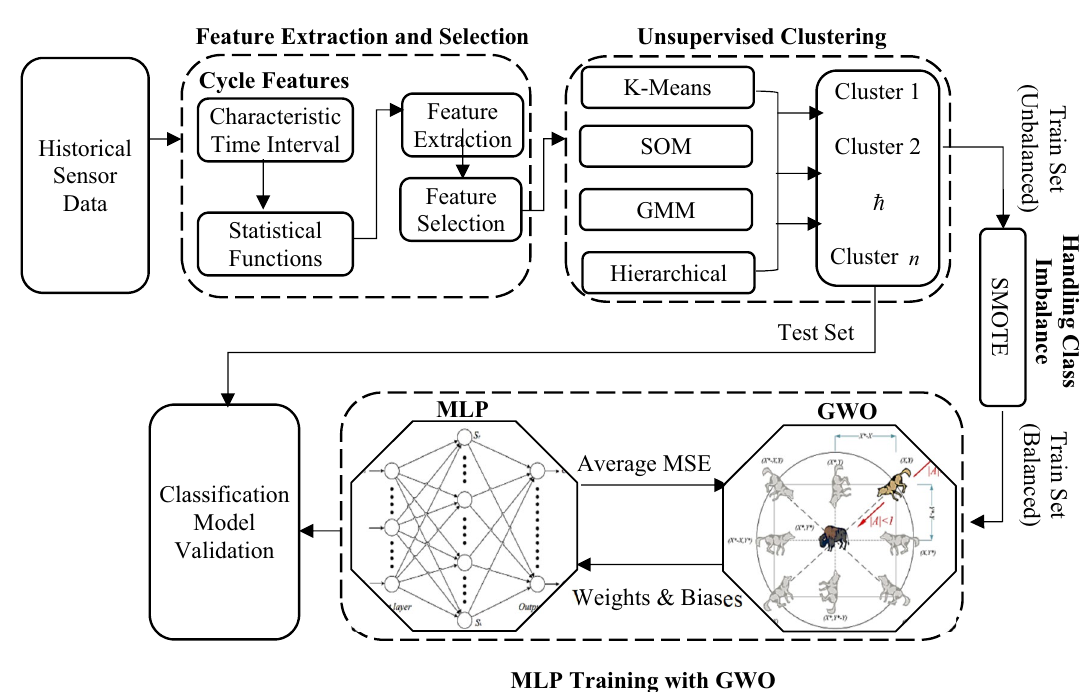
Fig. 1 Schematic of the proposed hybrid